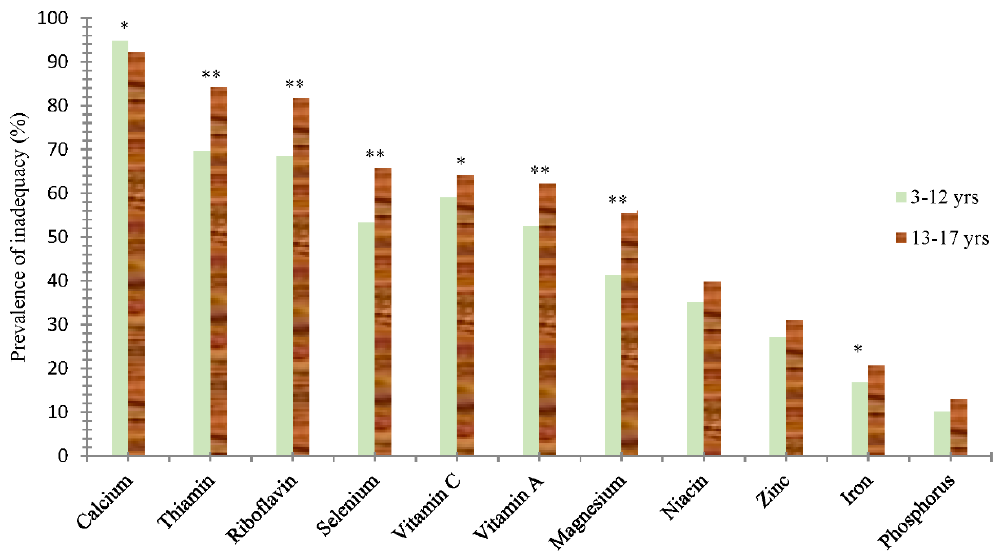
Figure 1. Prevalence of inadequacy of micronutrients. * Significant difference between two age groups, p < 0.05, ** p < 0.01.